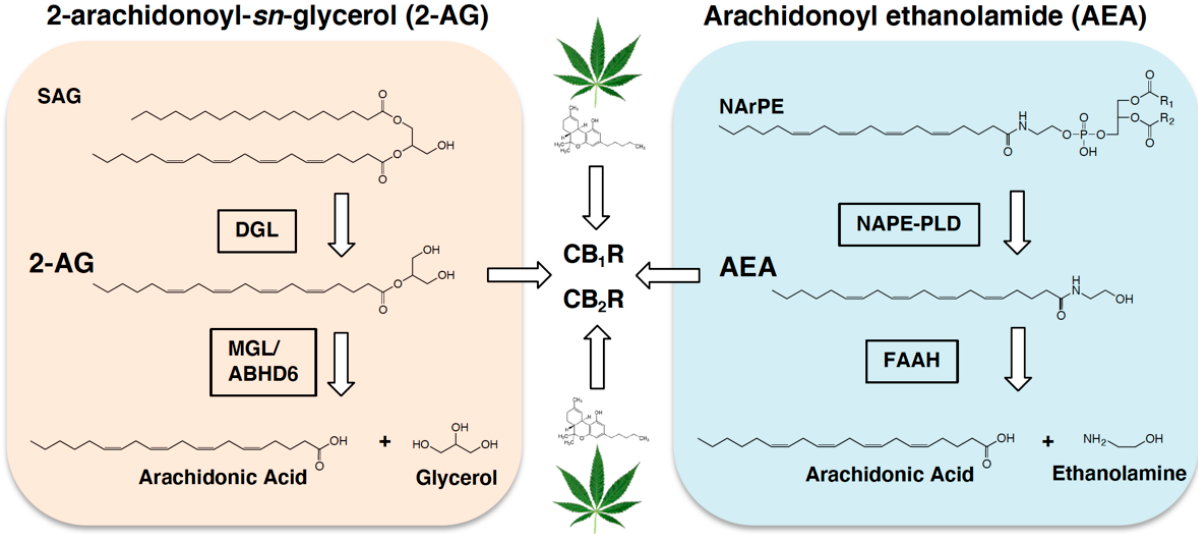
Figure 1. Endocannabinoid metabolic pathways. Biosynthesis of the endocannabinoid, 2-arachidonoyl- sn -glycerol (2-AG), is facilitated by diacylglycerol lipase- (DGL) dependent hydrolysis of the 2-AG precursor, 1,stearoyl,2-arachidonoyl- sn -glycerol (SAG). 2-AG is degraded by monoacylglycerol lipase (MGL), and to a lesser degree by alpha-beta-hydrolase domain 6 (ABHD6), into arachidonic acid and glycerol. Biosynthesis of the fatty acid ethanolamide, arachidonoyl ethanolamide (AEA, anandamide), is controlled by N -acylphosphatidylethanolamide phospholipase D- (NAPE-PLD) dependent hydrolysis of the AEA precursor, N -arachidonoylphosphatidylethanolamide (NArPE). AEA is degraded by fatty acid amide hydrolase (FAAH) into arachidonic acid and ethanolamine. 2-AG and AEA activate cannabinoid subtype-1 receptors (CB 1 R) and cannabinoid subtype-2 receptors (CB 2 R) in cells throughout the body (see for review [42,43]). Alternate endocannabinoid metabolic pathways have also been suggested. The primary intoxicating chemical in the cannabis plant, ∆ 9 tetrahydrocannabinol (THC, represented by the green leaf and corresponding THC molecule), hijacks the endocannabioid system and activates cannabinoid receptors in cells throughout the body.